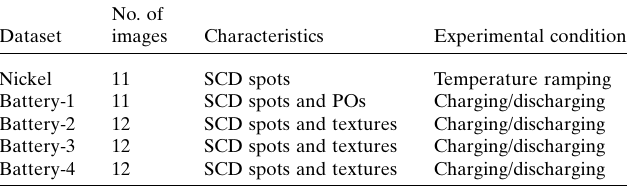
Table 1 Characteristics and experimental conditions of datasets. SCD spots and POs are single-crystal diffraction spots and preferred orientations, respectively.